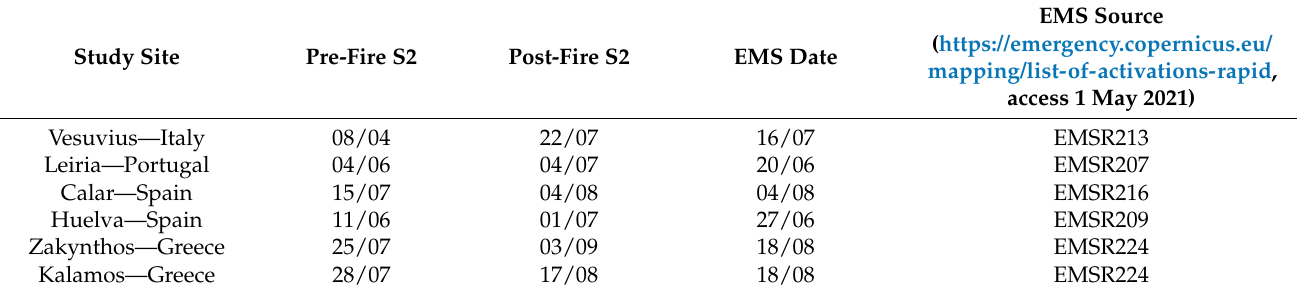
Table 2. Pre- and post-fire S2 dates over the six sites, reference date and source for the EMS products.